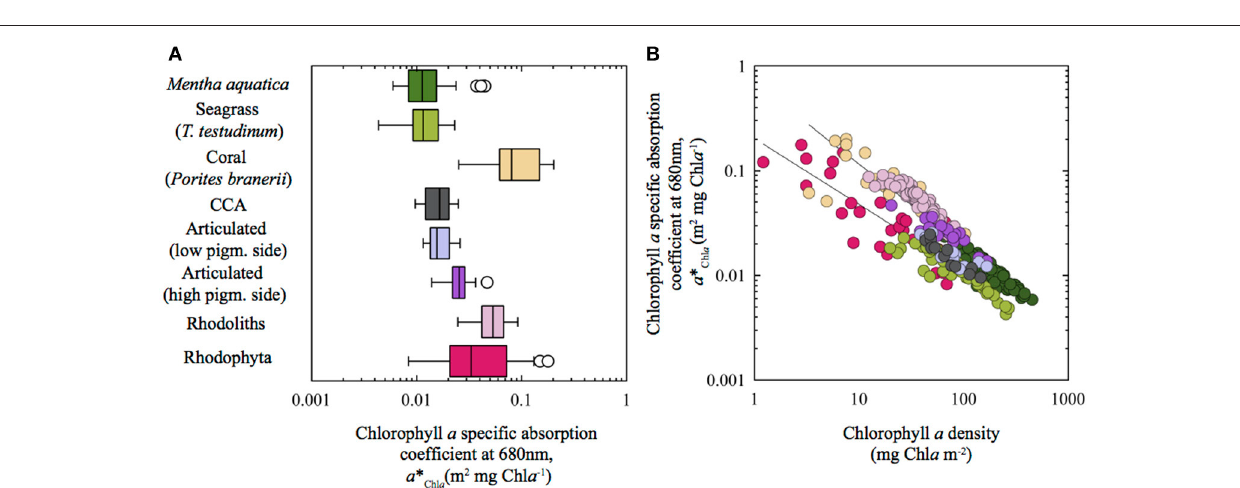
FIGURE 7 | Inter-specific variation of pigment specific absorption for the Chl a red peak ( a * Chl a ) across different aquatic photosynthetic structures: (A) Box plot showing a * Chl a variation for the different species characterized; and (B) log/log variation of a * Chl a as a function of changes in chlorophyll a density (mg Chl a m − 2 ). Data from: Corallines (this study); Rhodophyta ( Enríquez et al., 1994); Mentha aquatica (Enríquez and Sand-Jensen, 2003); coral Porites branerii (Enríquez et al., 2005); Thalassia testudinum (Enríquez, 2005). Trend lines in (B) correspond to power function fits [y = a * x b ] for: (1) Rhodophyta and T. testudinum (bottom trend line) and, (2) corallines (rhodoliths, articulated and CCA), Porites branerii and Mentha aquatica . LS regression analysis of the log-log transformed data: For fit (1), log a * Pigm = − 0.69 ( ± 0.10) – 0.63 ( ± 0.08)* log Chl a ( R 2 = 0.76, n = 26, SE = 0.21, P < 0.001; for fit (2), log a * Pigm = − 0.15 ( ± 0.07) – 0.91 ( ± 0.04)* log Chl a ( R 2 = 0.68, n = 123, SE = 0.15, P <